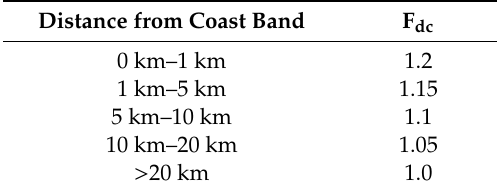
Table 1. Values for the distance from coast band factor (F dc ).